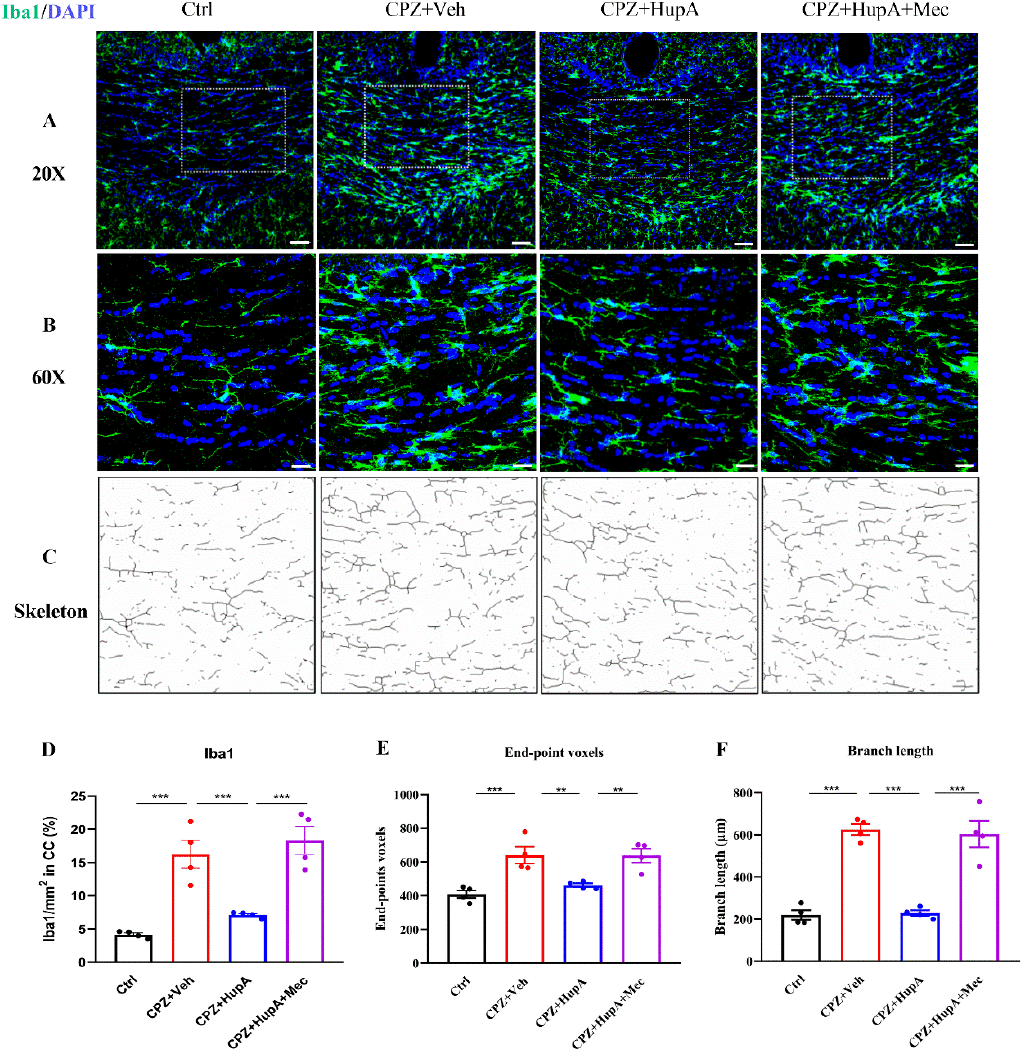
Figure 6. HupA treatment reduced the quantity of microglia in the corpus callosum. ( A , B ) Iba1 IHC. ( C ) Morphological analysis of the structure of microglia. ( D – F ) Quantitative analysis of the proportion of microglia in the corpus callosum, the number of branch ends, and total branch length. The results represent the mean ± SEM (** p < 0.01, *** p < 0.001, n = 4 mice per